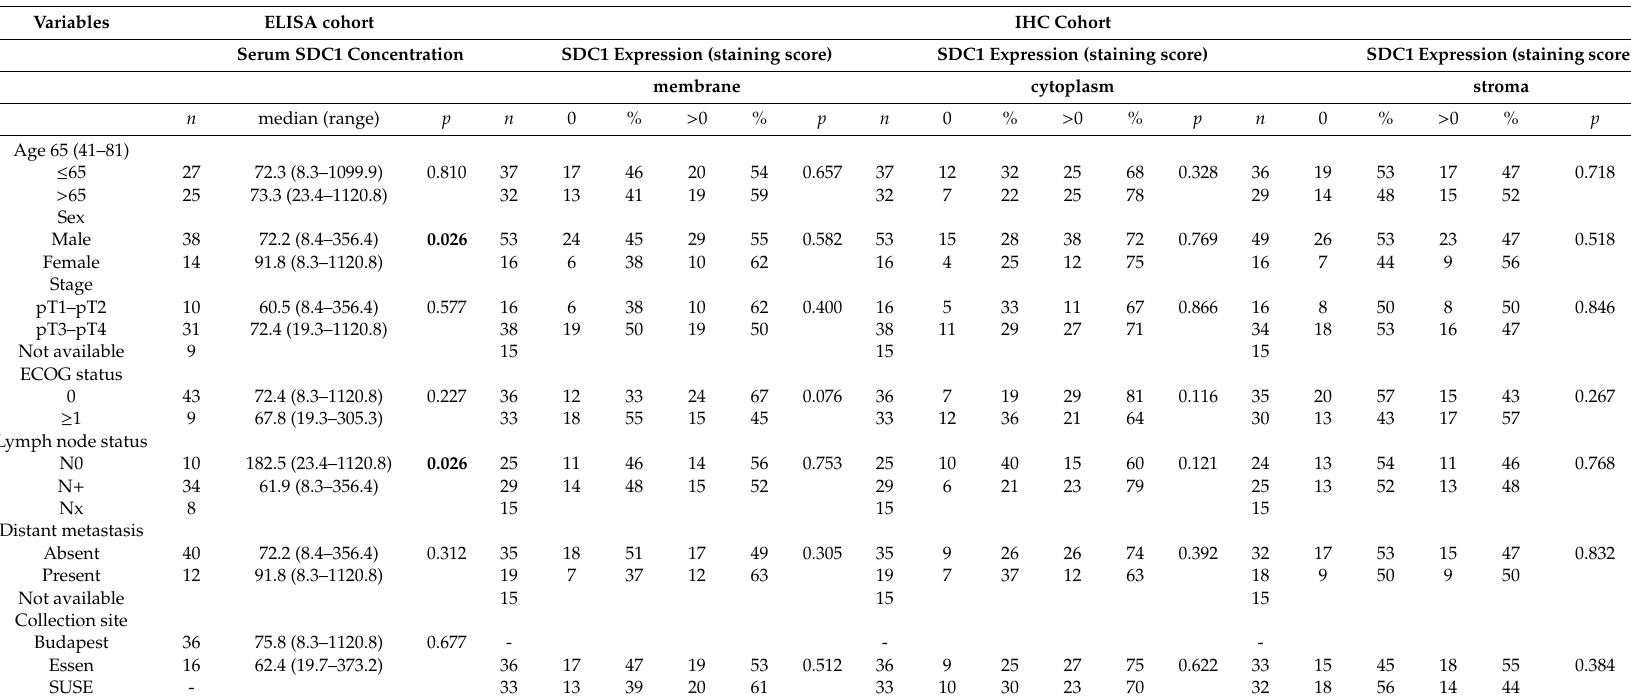
Table 2. Syndecan-1 (SDC1) serum and tissue levels and clinicopathological parameters. ECOG—Eastern Cooperative Oncology Group. Bold printed p -values were significant ( <